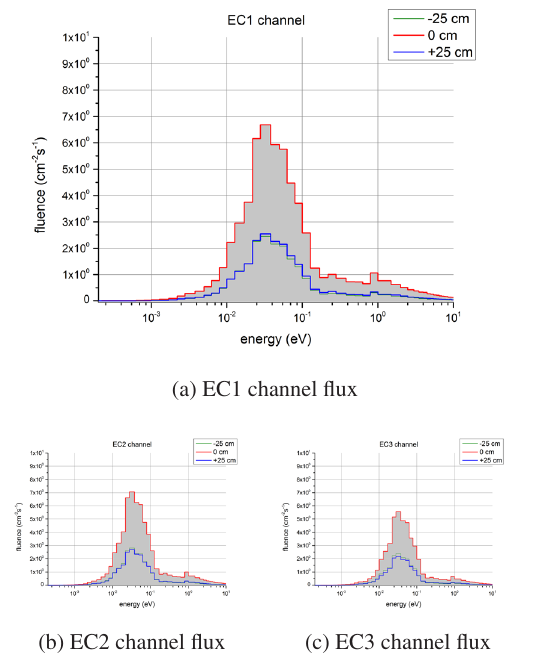
Figure 5: 235 U fission rate and thermal neutron flux